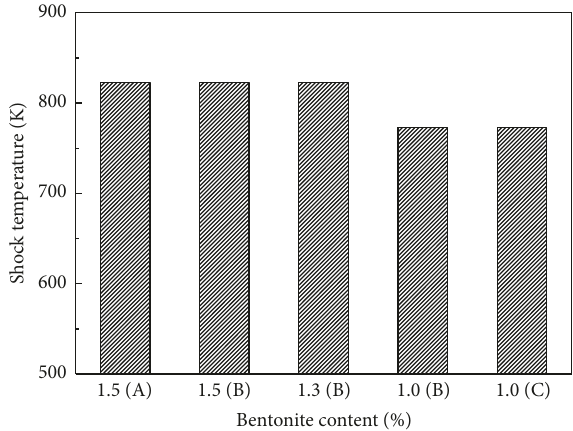
Figure 7: Effect of different types and proportions of bentonite on the shock temperature of the